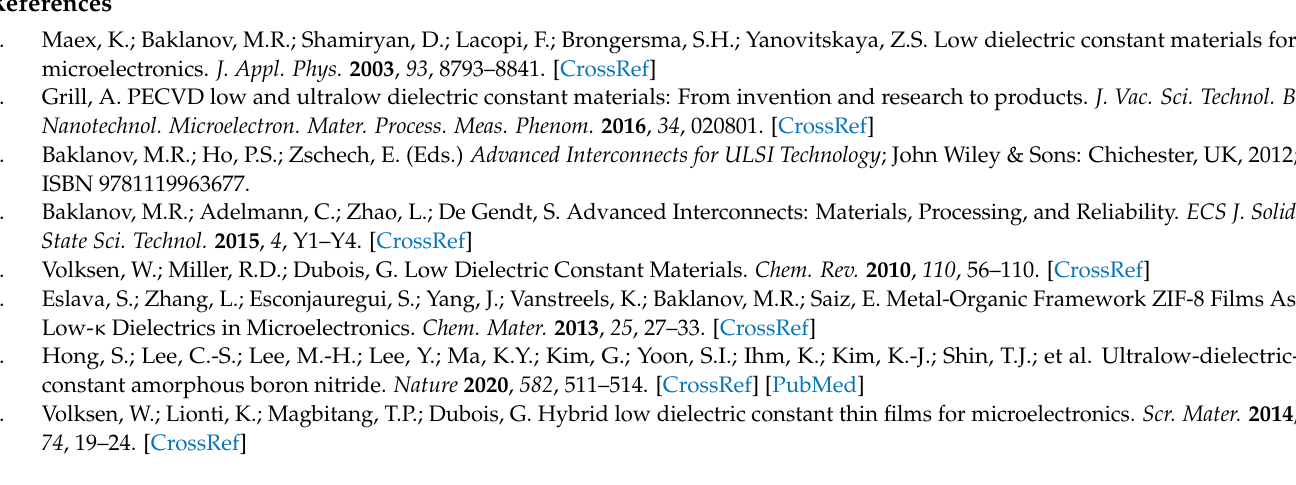
Figure S1: FTIR spectra of 1:7 ratio as-deposited (AD) films with different template loadings (0 to 41 wt%, films numbered from HC17 to HC41); where (a) full FTIR spectra; and (b–d) are the parts of the full FTIR spectra, Figure S2: FTIR spectra of 1:3 ratio material films hard baked (HB) in N 2 (60 min) with different template loadings (0 to 41 wt%, films numbered from HC17 to HC41); where (a) full FTIR spectra; and (b–d) are the parts of the full FTIR spectra, Figure S3: Fingerprint region (3800–2800 cm − 1 ) of FTIR spectra of (a) N 2 cured for 60 min (just cured) and the corresponding (b) one-month stored samples with different porogen (0 to 41 wt%, films numbered from HC17 to HC41) loadings. Figure S4: Ranges of FTIR spectra for 1:7 material after (a) hard baking (HB) at 400 ◦ C in N 2 for 60 min (N 2 cured), (b) annealing at 500 ◦ C for 30 min, and (c) annealing at 600 ◦ C for 30 min with different porogen (from 0 to 41 wt%, films numbered from HC17 to HC41)